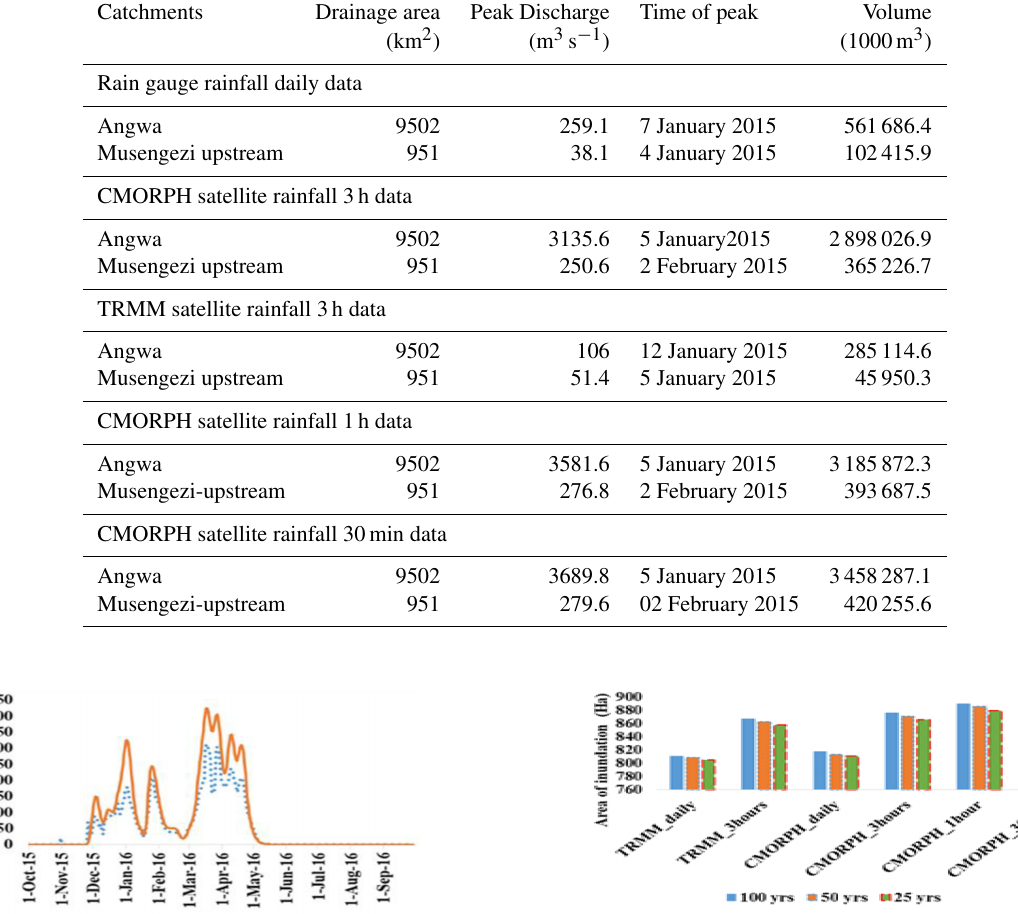
Table 1. Characteristics of catchments acquired from the model basing on different timestep for both satellite rainfall products for October